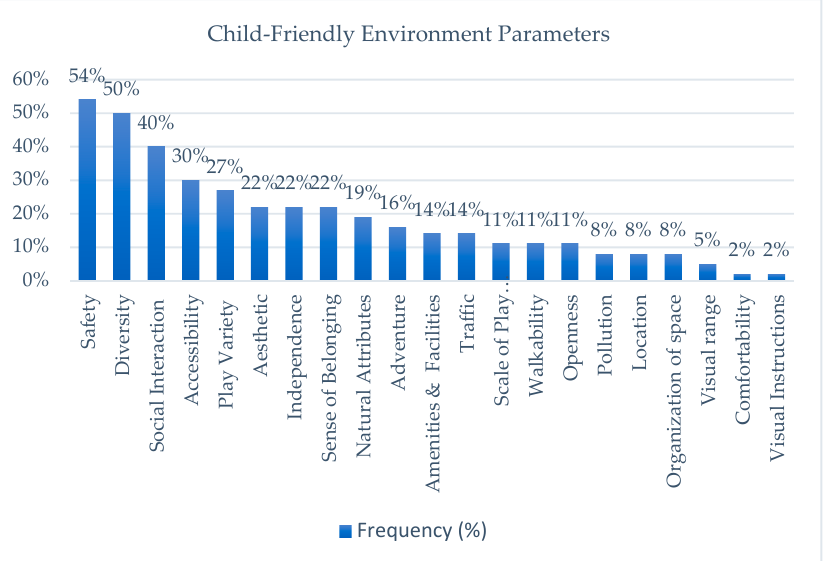
Figure 4. Findings of the literature review.